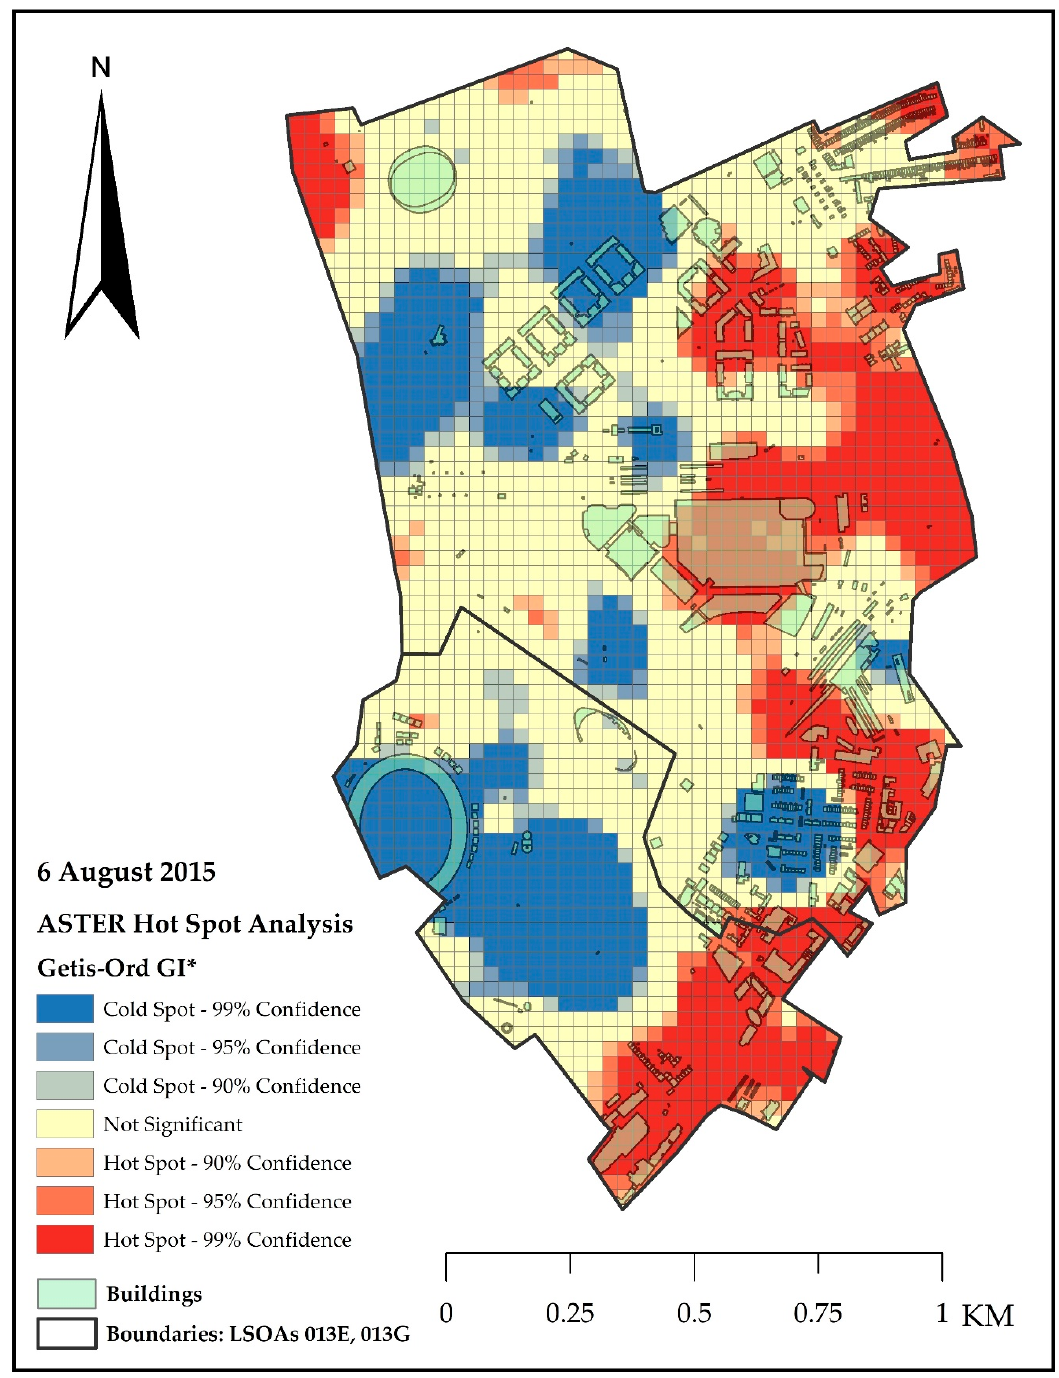
Figure 11. Hot spot results of temperature cluster analysis for LSOAs 013E and 013G, calculated from 6 August 2015 ASTER image, overlain by buildings polygons. Contains National Statistics data © Crown copyright and database right (2015) and (2012). Contains Ordnance Survey data © Crown Copyright and database right [2015/2012], and also OS VectorMap ® Local [SHAPE geospatial data], Scale 1:10,000, Tiles: tq38ne, tq38se. Updated: 1 April 2016, Ordnance Survey (GB), Using: EDINA Digimap Ordnance Survey Service, <http://digimap.edina.ac.uk>, Downloaded: 8 December 2016 17:58:35.615.